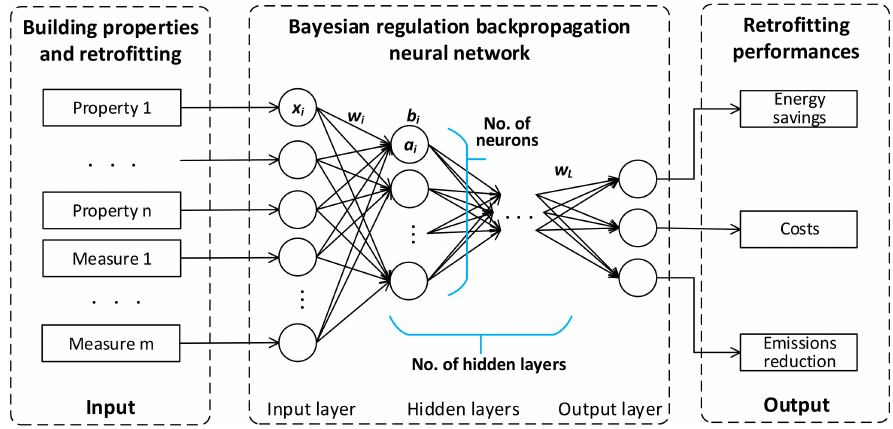
Figure 2. The overall structure of BRBNN for performance